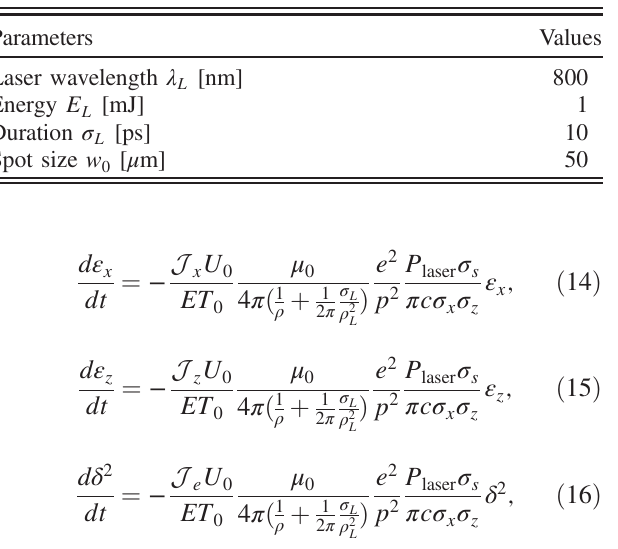
TABLE III. The parameters of laser pulses at the interaction